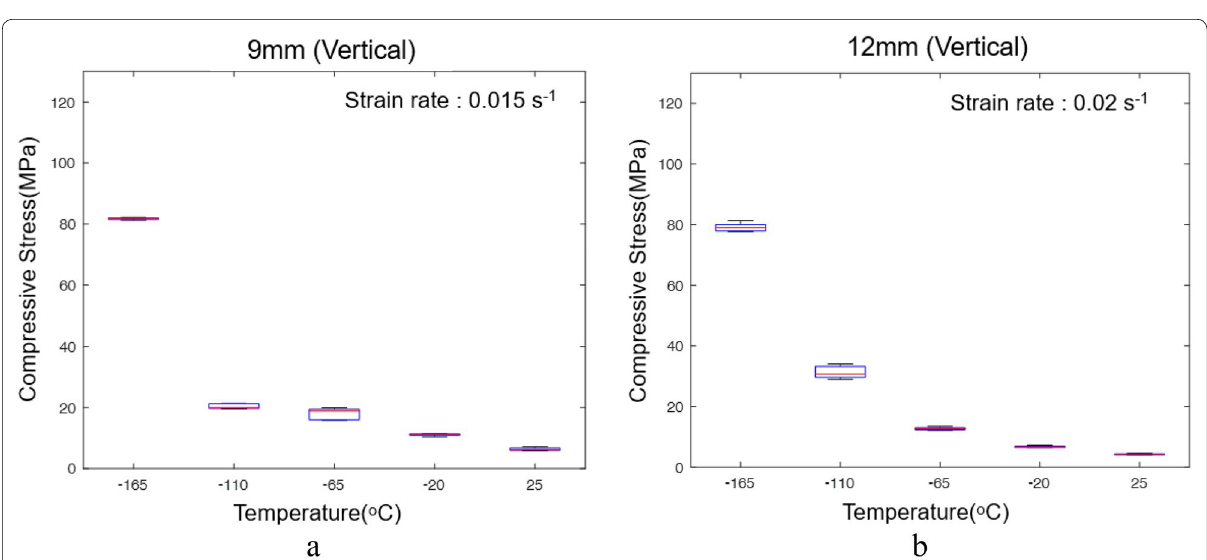
Fig. 13 a , b Average compressive strength of plywood in the vertical fiber